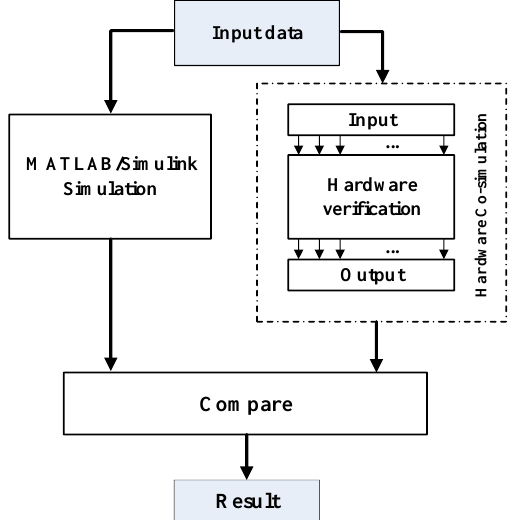
Figure 8. The verification flow for the proposed technique with the system generator tool using MATLAB simulation and FPGA in-the-loop